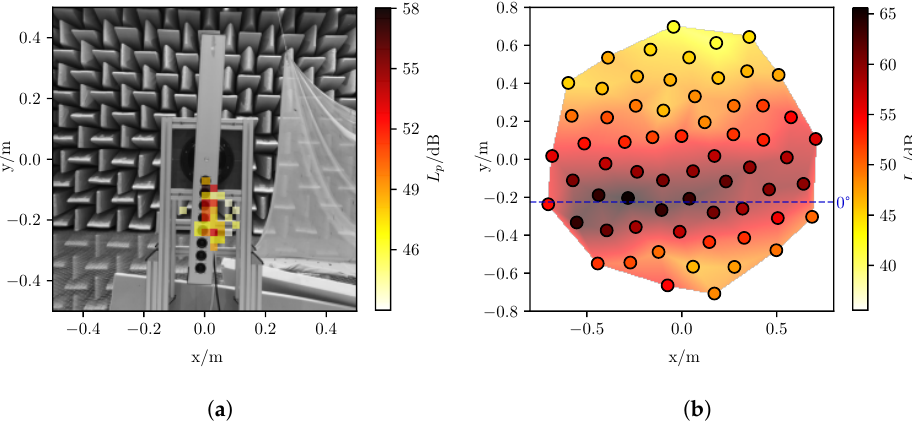
Figure 5. Test case 2 with a rotating speaker array and no signal delay between the speakers: ( a ) source distribution; ( b ) source directivity in the direction of the microphones at the 5 kHz octave band. The blue dotted line indicates the theoretical maximum at 0 ◦ .